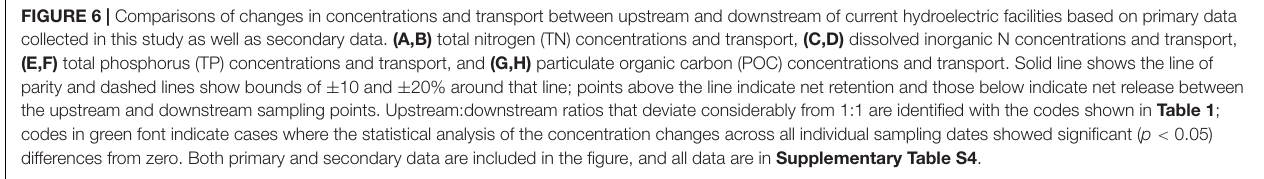
FIGURE 6 | Comparisons of changes in concentrations and transport between upstream and downstream of current hydroelectric facilities based on primary data collected in this study as well as secondary data. (A,B) total nitrogen (TN) concentrations and transport, (C,D) dissolved inorganic N concentrations and transport, (E,F) total phosphorus (TP) concentrations and transport, and (G,H) particulate organic carbon (POC) concentrations and transport. Solid line shows the line of parity and dashed lines show bounds of ± 10 and ± 20% around that line; points above the line indicate net retention and those below indicate net release between the upstream and downstream sampling points. Upstream:downstream ratios that deviate considerably from 1:1 are identified with the codes shown in Table 1 ; codes in green font indicate cases where the statistical analysis of the concentration changes across all individual sampling dates showed significant ( p < 0.05) differences from zero. Both primary and secondary data are included in the figure, and all data are in Supplementary Table S4 .